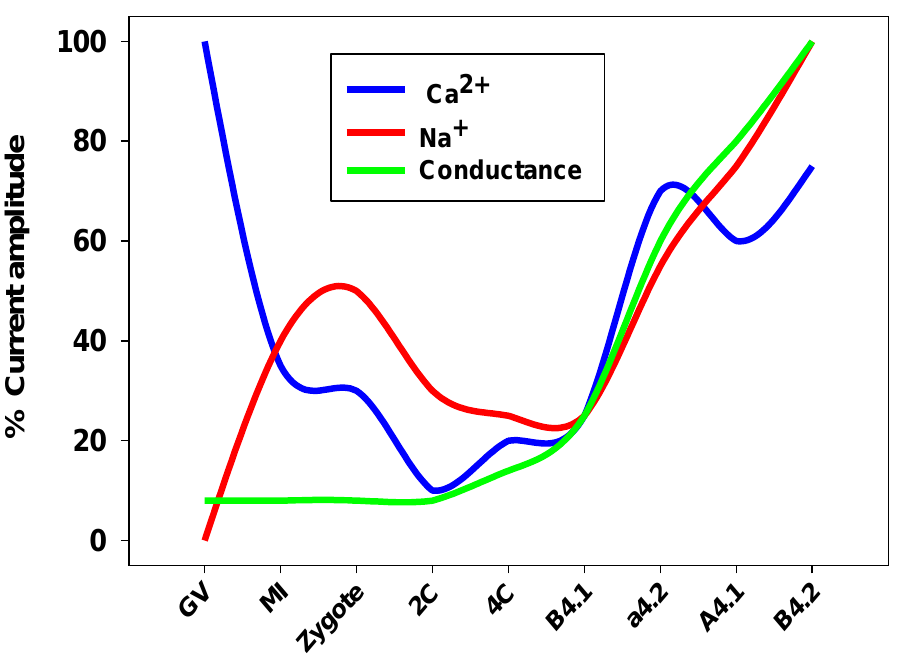
Figure 2. Ion currents in Ciona robusta oocytes and embryo in different developmental stages. GV (germinal vesicle, immature oocyte), MI (metaphase I stage oocyte), 2C (2-cell stage), 4C (4-cell stage). B4.1, a4.2, A4.1, and B4.2 are blastomeres belonging to the 8-cell stage embryo.